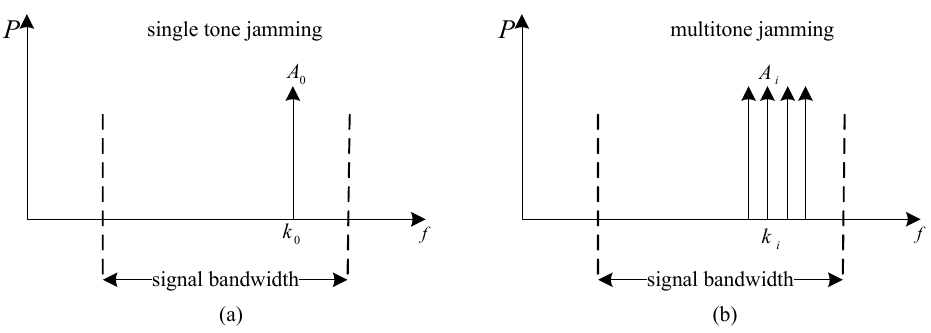
Figure 1. Power spectrum of NBI. ( a ) single tone jamming; ( b ) multitone